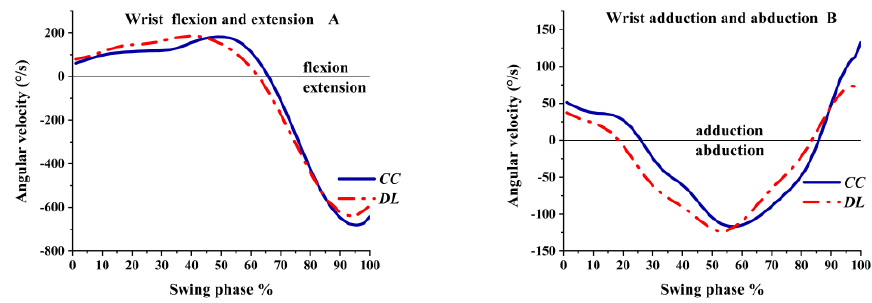
Figure 7. The angular velocity of the wrist during the swing phase.